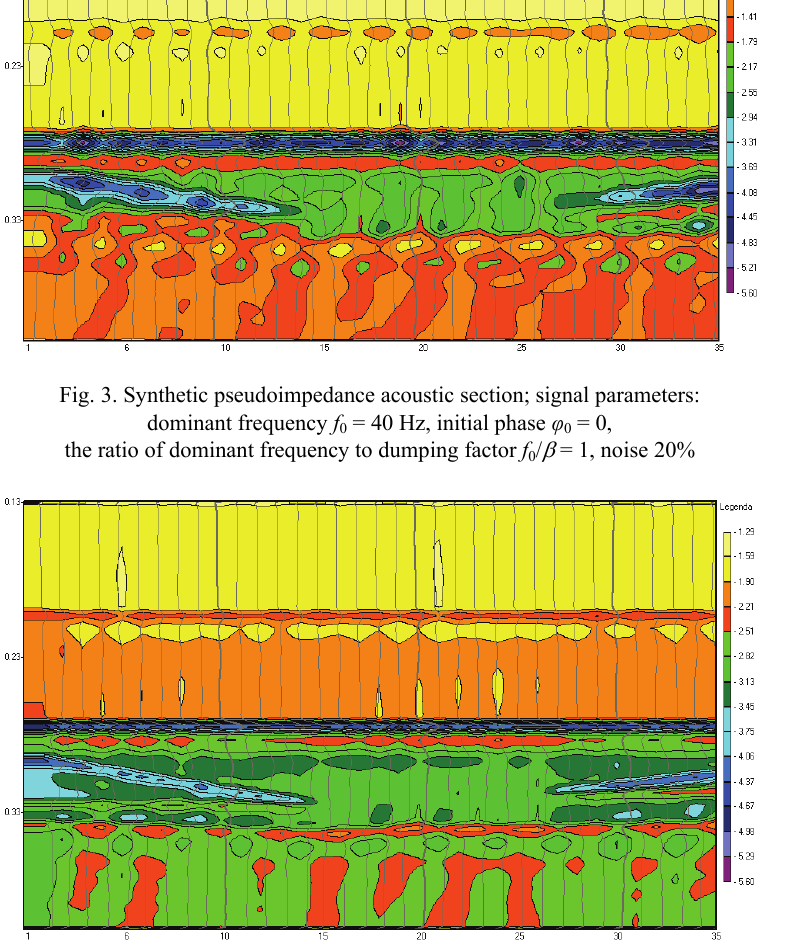
Fig. 4. Synthetic pseudoimpedance acoustic section with predictive deconvolution; signal parameters: dominant frequency f 0 = 40 Hz, initial phase φ 0 = 0, the ratio of dominant frequency to dumping factor f 0 / β = 1, noise 20%